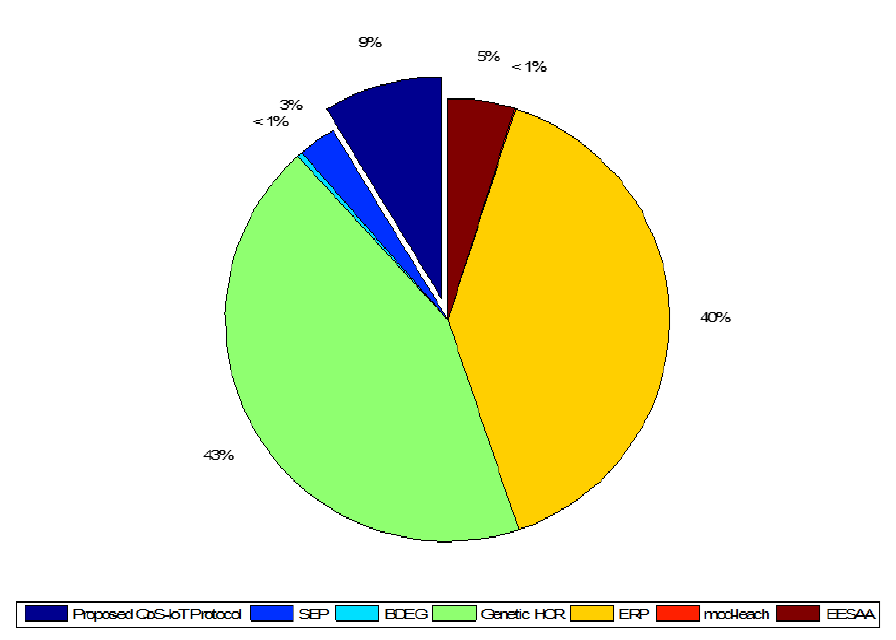
Figure 7. Comparison of standard deviation of the network